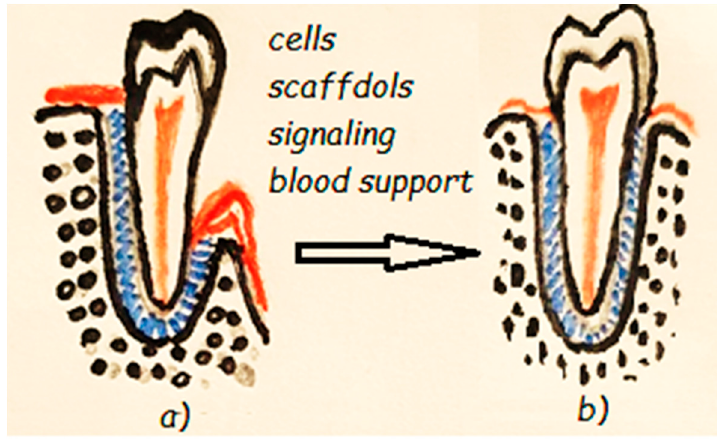
Figure 4. Periodontal tissue regeneration: ( a ) diseased periodontium, ( b ) regenerated periodontium.